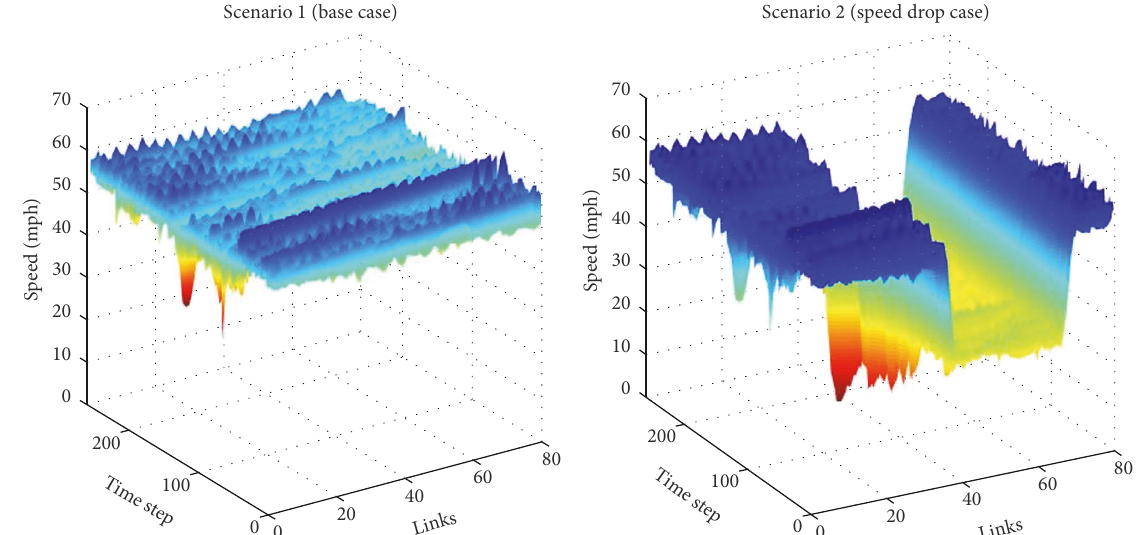
Figure 4: Speed comparison under normal condition and with a speed reduction zone.